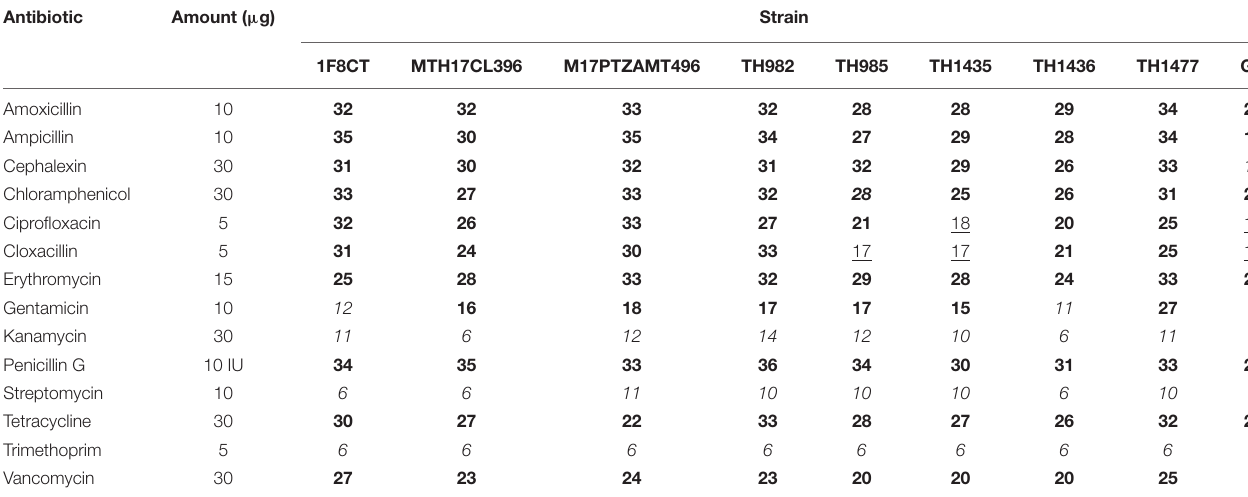
TABLE 2 | Antibiotic susceptibility of S. thermophilus strains measured as diameters (mm) of inhibition haloes.